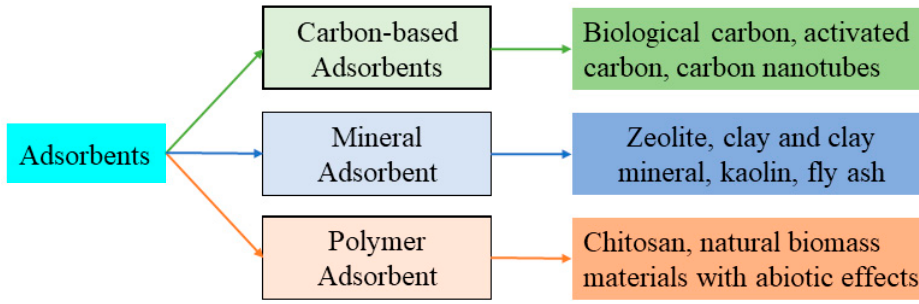
Figure 3. Common adsorbent types in Cu(II) removal process.